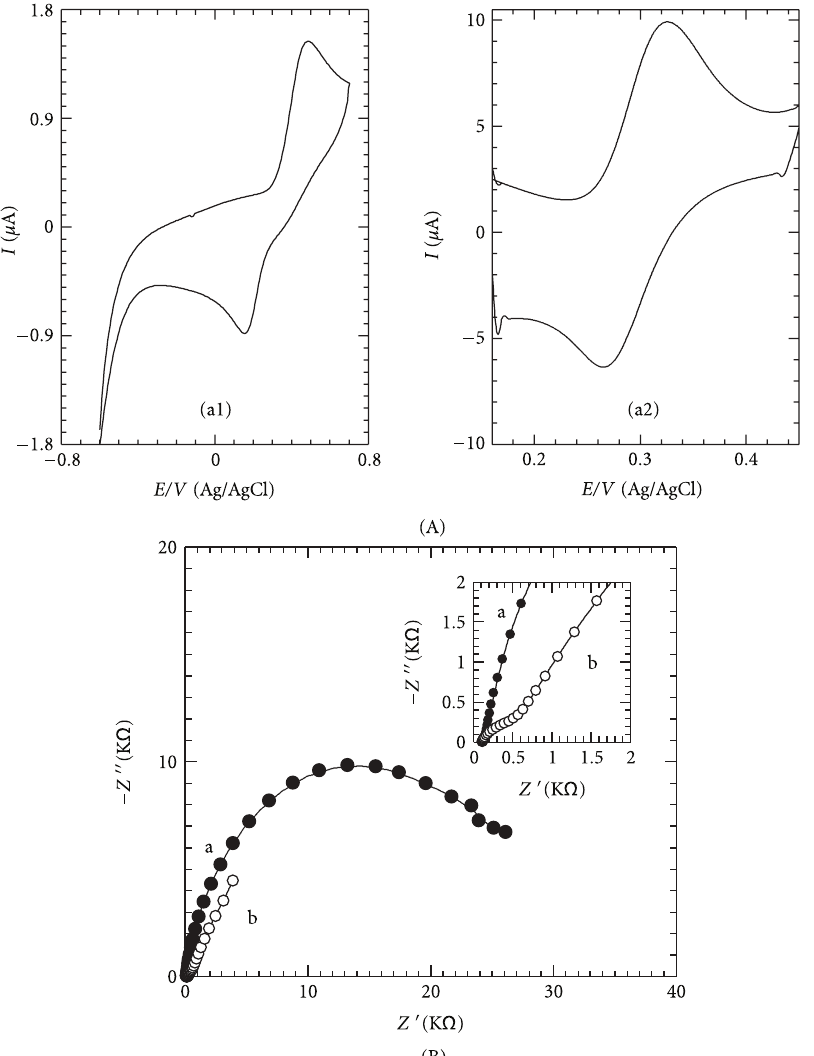
Figure 4: (A) Cyclic voltammograms obtained on the bare GC (a1) and GC/RuOHCF/RuHCF modified (a2) electrodes in the presence of 0.2mMDA at pH 5. Scan rate 100mV/s. (B) Complex plane plots obtained in 0.1M NH 4 NO 3 in the presence of 1mM DA at pH 5 on (a) the bare GC, and (b) GC/RuOHCF/RuHCF modified electrodes. E DC = +0.260V versus Ag/AgCl, E ac = 15mV, and frequency range: 10 kHz to 10mHz.